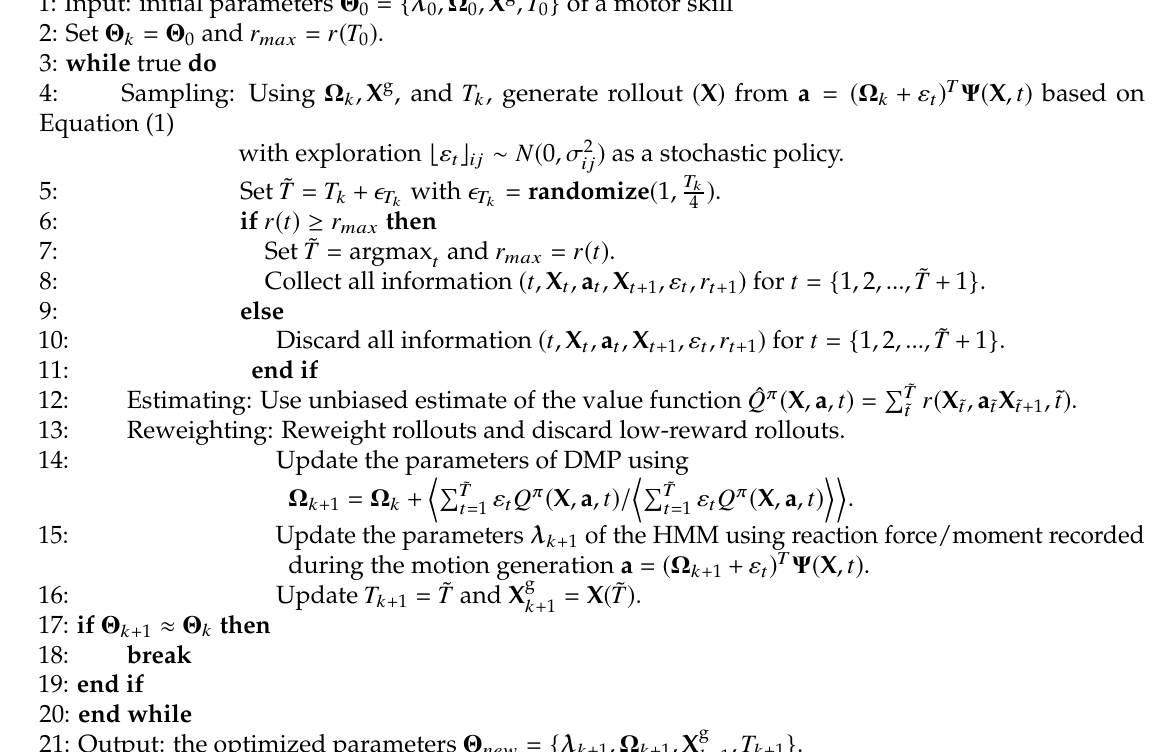
Algorithm 3 gPoWER algorithm for generalizing motor skills to add new motor skills and new